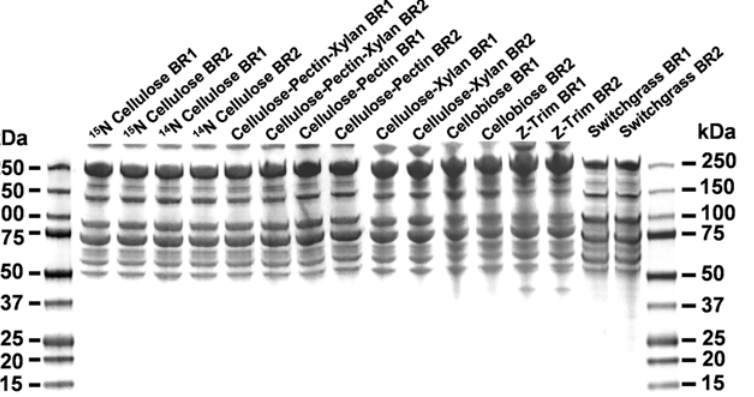
Figure 3. Clostridiumthermocellum cellulosomal protein profile during growth on various substrates, analyzed by protein gel electrophoresis. SDS-PAGE (4–20% Tris-HEPES-Glycine gel, coommassie stain) separation of Clostridium thermocellum cellulosomal fractions isolated using the affinity digestion method from cell-free broth of duplicate fermentations during growth on pretreated switchgrass and other biomass carbohydrates. BR1, 2=Biological Replicate 1, 2,